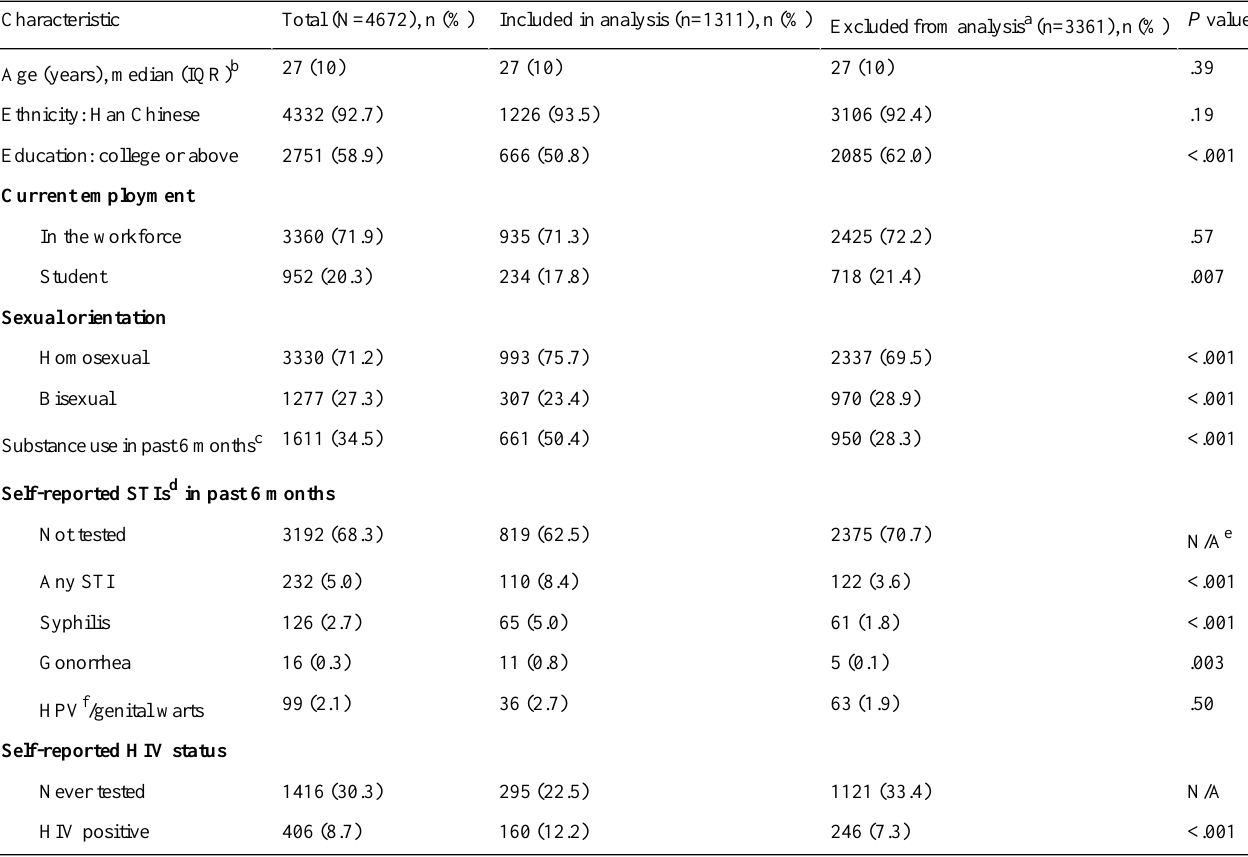
Table 1. Characteristics of 4672 surveyed adult Blued app users in 4 provinces in China.